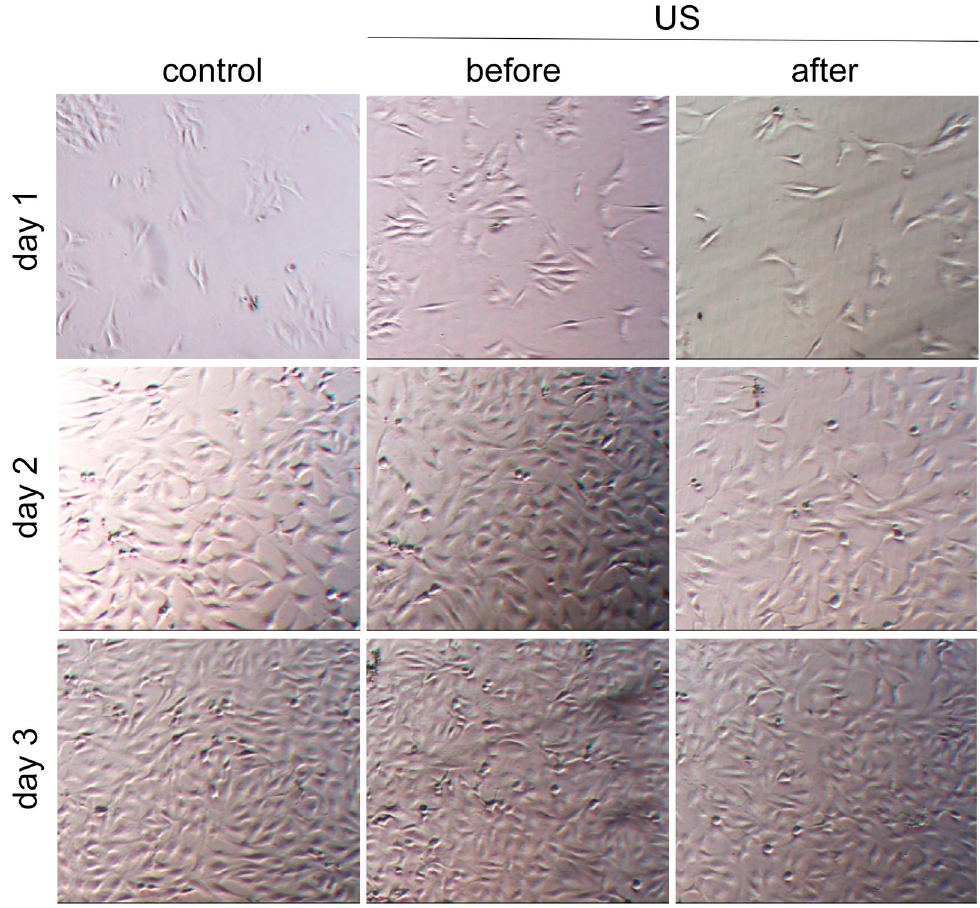
Fig 2. Application of LIPUS. Representatives phase contrast images of human s-MPs showing control cells and LIPUS- stimulated (US) cells before and after consecutive treatment during 3